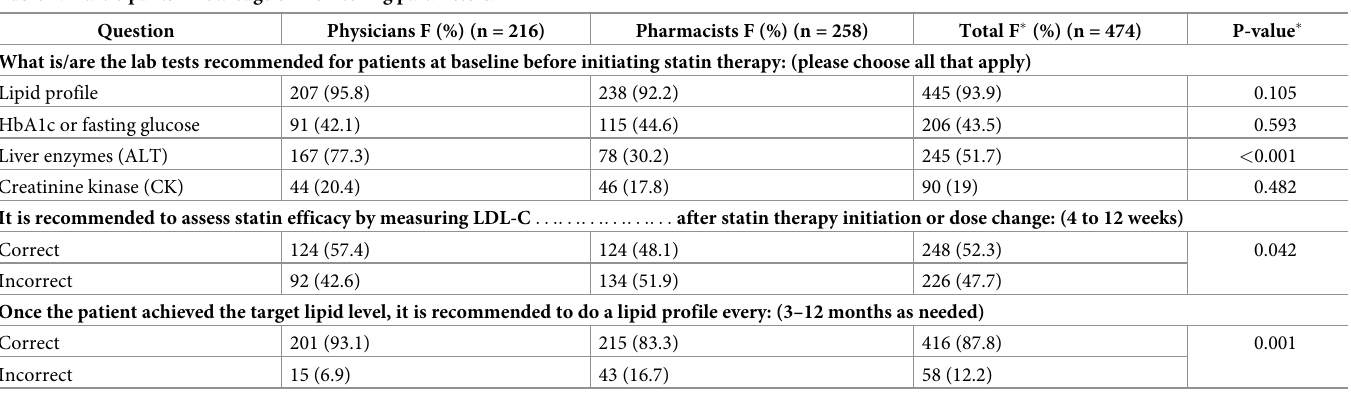
Table 4. Participants’ knowledge of monitoring parameters.